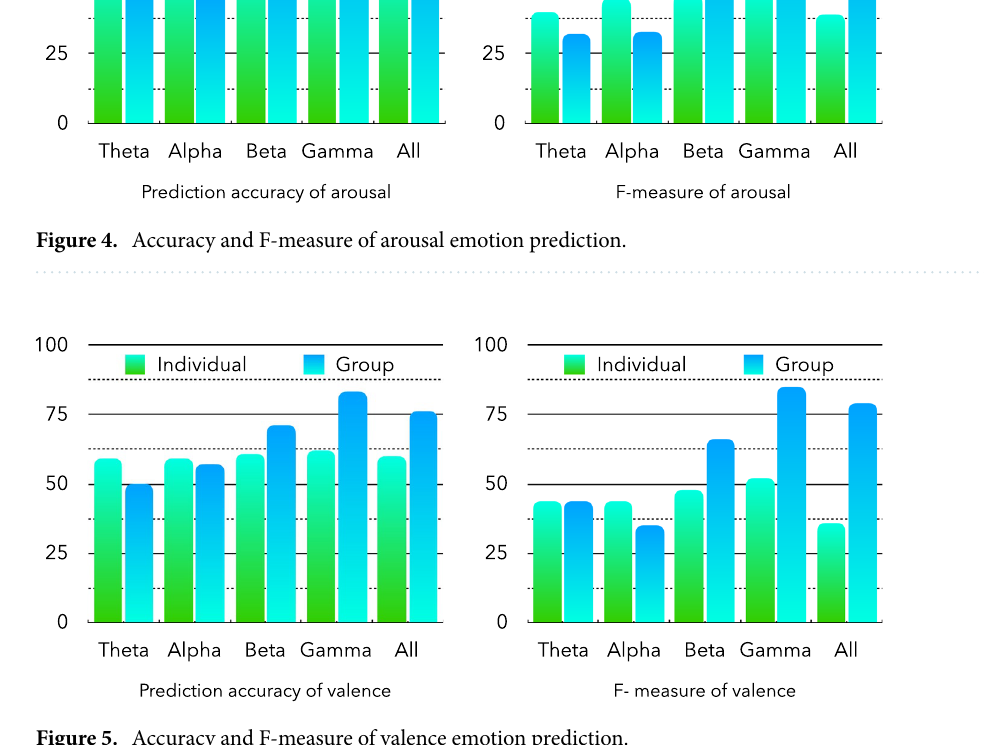
Figure 5. Accuracy and F-measure of valence emotion prediction.